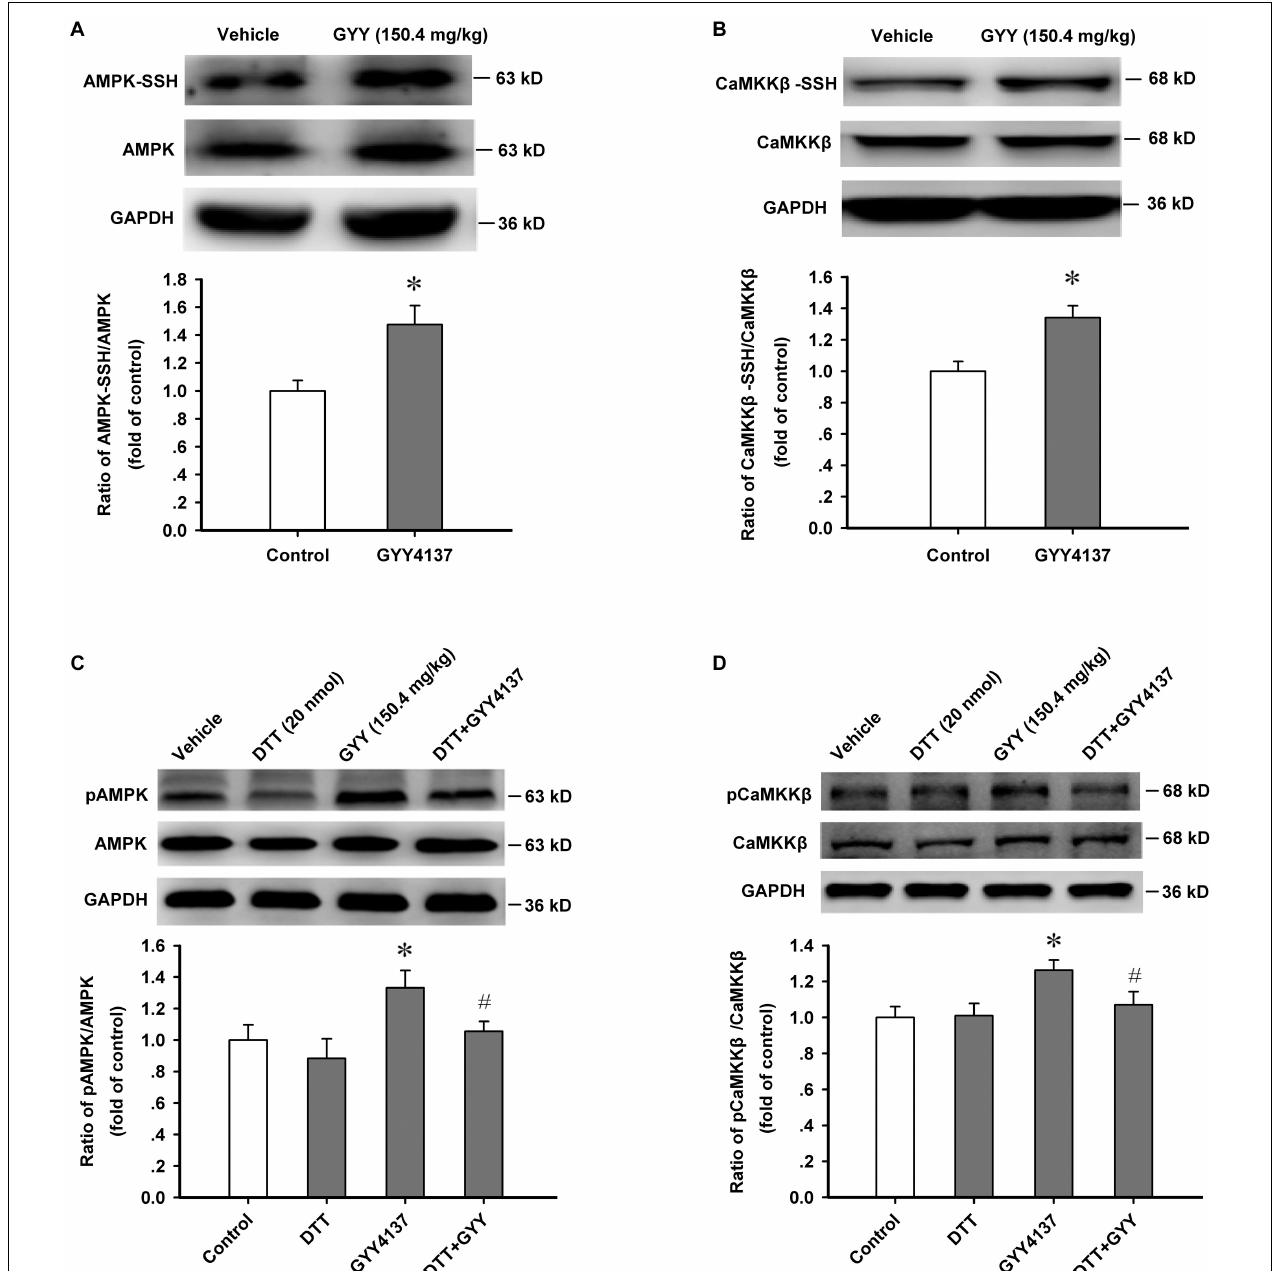
FIGURE 5 | Protein sulfur-sulfhydrylation mediates GYY4137-induced activation of AMPK and CaMKK β . (A) GYY4137 (150.4 mg/kg) increased the sulfur-sulfhydrylation level of AMPK in ARC tissue ( n = 4). (B) GYY4137 (150.4 mg/kg) increased the sulfur-sulfhydrylation level of CaMKK β in ARC tissue ( n = 4). (C) DTT (20 nmol each mouse) attenuated the increased activation of AMPK induced by GYY4137 (150.4 mg/kg) in ARC tissue ( n = 4). (D) DTT (20 nmol each mouse) attenuated the increased activation of CaMKK β induced by GYY4137 (150.4 mg/kg) in ARC tissue ( n = 4). Data are normalized as folds to control and expressed as means ± SEM. One-way ANOVA and post hoc tests were used. ∗ P < 0.05 vs vehicle; # P < 0.05 vs